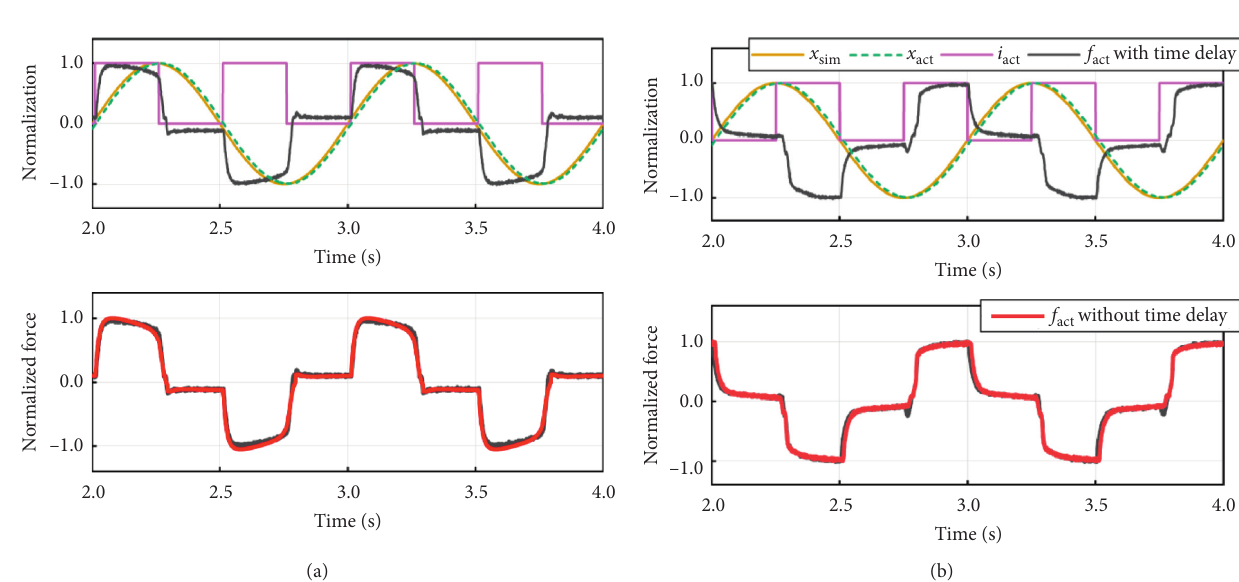
Figure 4: Normalized inputs and responses. (a) Case A. (b) Case